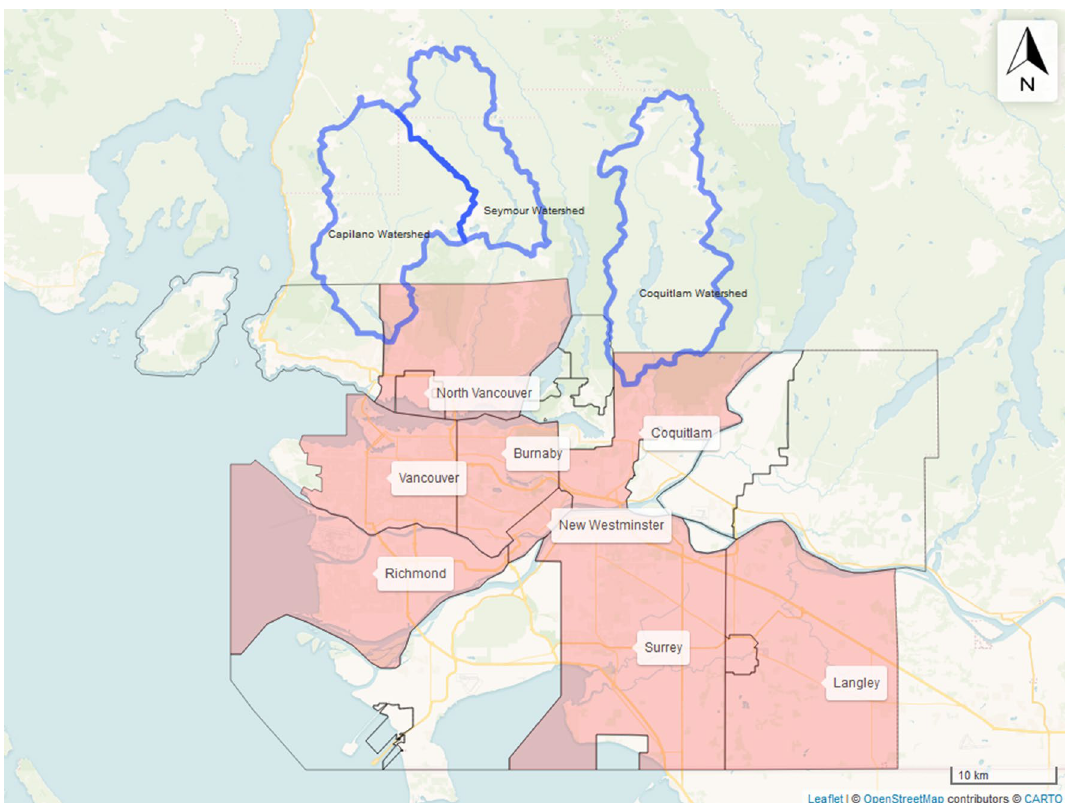
Figure 3. Map of MV with the shaded areas representing sampled municipalities. This map was generated using R version 4.0.3 (https:// www.R- proje ct. org/) 58,81